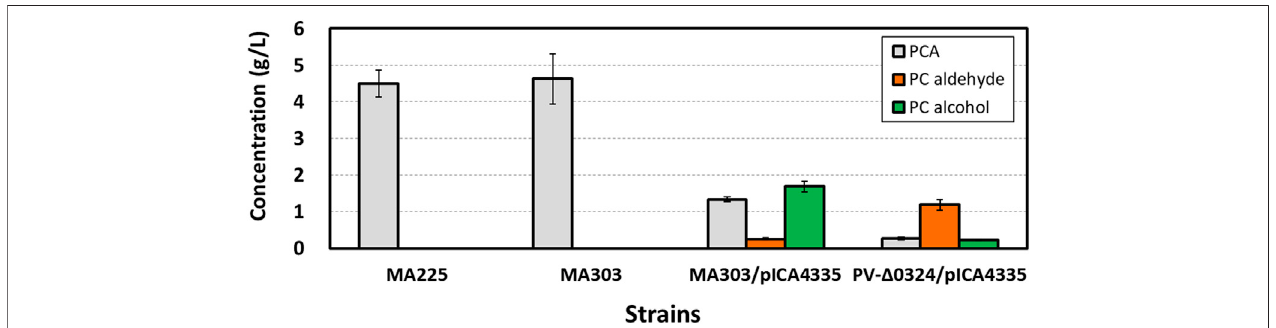
FIGURE 3 | Effect of NCgl0324 deletion on the production of protocatechuate, protocatechuic aldehyde, and protocatechuic alcohol by C. glutamicum mutants harboringthe car -expressing pICA4335 plasmid in fl askculture. Cellsweregrown ina fl askfermentationmedium for42 – 48 hat32 ° Cwithvigorous shaking at240 rpm. Mean and standard deviation of triplicate cultivation are